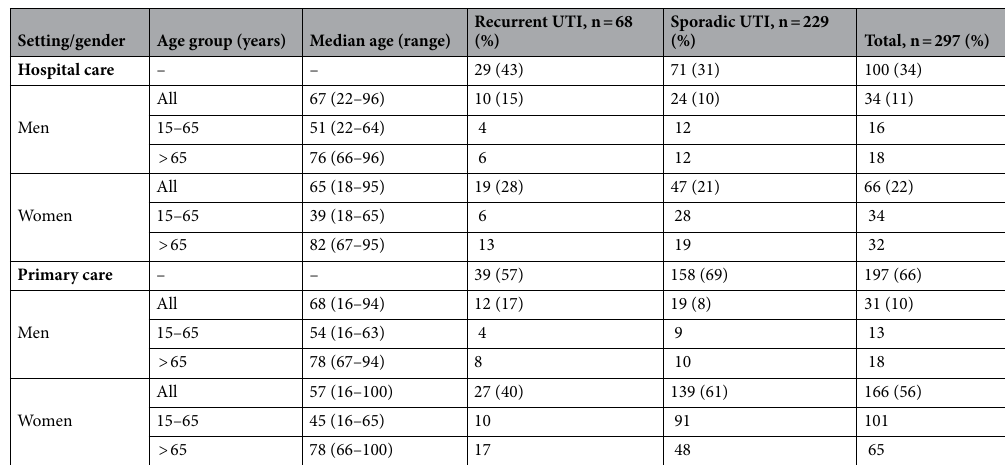
Table 1. Patient demographics for 297 patients in relation to sporadic or recurrent UTI caused by ESBL- producing E.